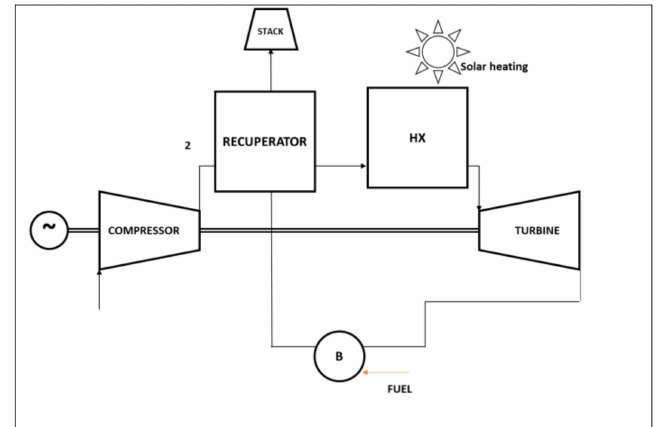
Figure 12. Solar—EFMGT layout